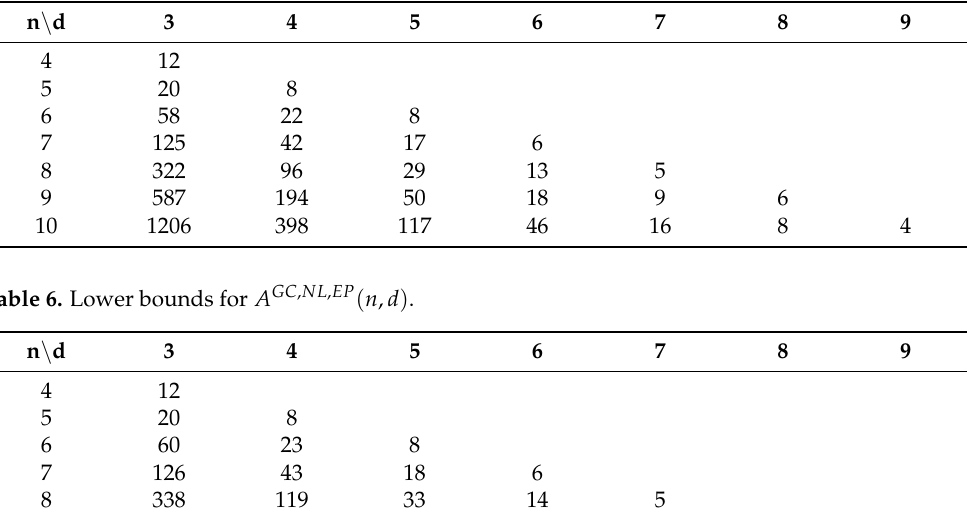
Table 5. Lower bounds for A GC , NL , DM ( n , d ) .